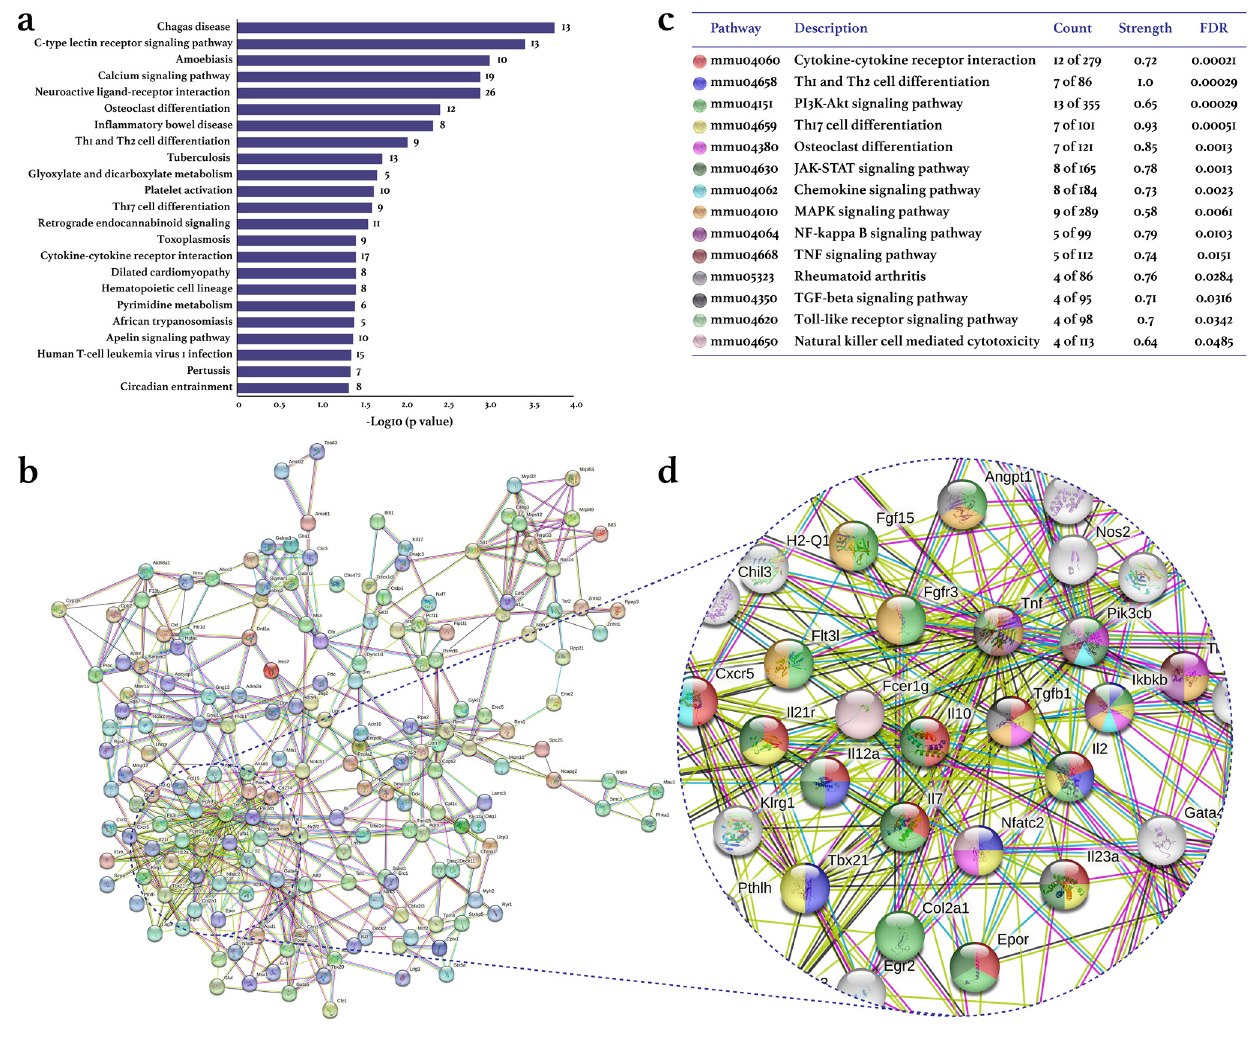
Figure 2. Effect of physical exercise on transcriptomic down-expression in tarsal joints of mice with collagen-induced arthritis. The lists of the down-expressed genes in the CIA-Ex mice with respect to control (Z-score ≥ 1.5 SD) were analyzed on DAVID bioinformatics resource, STRING database, and Cytoscape software (n = 8 mice per group). ( a ) The associated KEGG pathways ( p ≤ 0.05) in DAVID are shown in the bars that indicate the -Log10 ( p -value) and the number of genes on the right side of each bar. ( b ) The primary clusters of sub-networks found with the Molecular Complex Detection (MCODE) complement (cutoff = 0.4) to obtain the protein–protein interaction (PPI) network. ( c ) KEGG signaling pathways relevant in arthritis. ( d ) Amplification of the nodes with the most significant interaction in the selected pathways. FDR: false discovery rate.